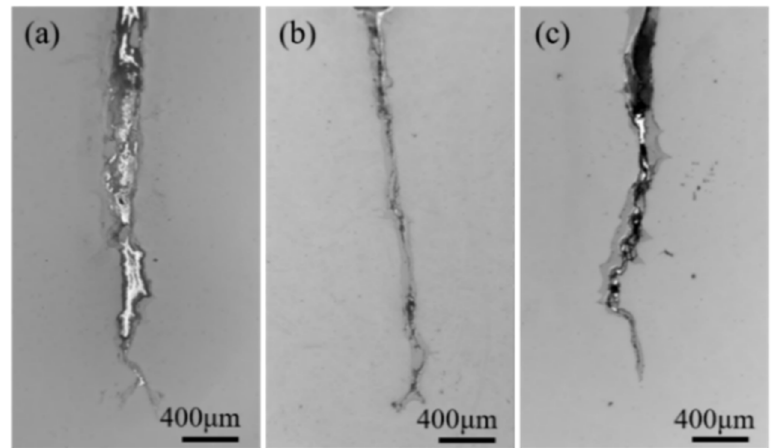
Figure 4. Crack morphology of three materials after 2000 cycles: ( a ) ZG1; ( b ) ZG2; ( c ) ZG3.